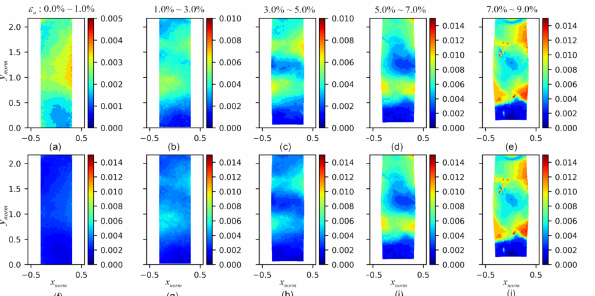
Figure 8. The evolution of the standard deviation fields of gradient along the ˆ ρ axis F 11 : ( a – e ) the standard deviation fields of F 11 at axial strains of 0.0–1.0%, 1.0–3.0%, 3.0–5.0%, 5.0–7.0%, and 7.0–9.0%, respectively, with varying range colormaps; ( f – j ) the standard deviation fields of F 11 at axial strains of 0.0–1.0%, 1.0–3.0%, 3.0–5.0%, 5.0–7.0%, and 7.0–9.0%, respectively, with consistent range